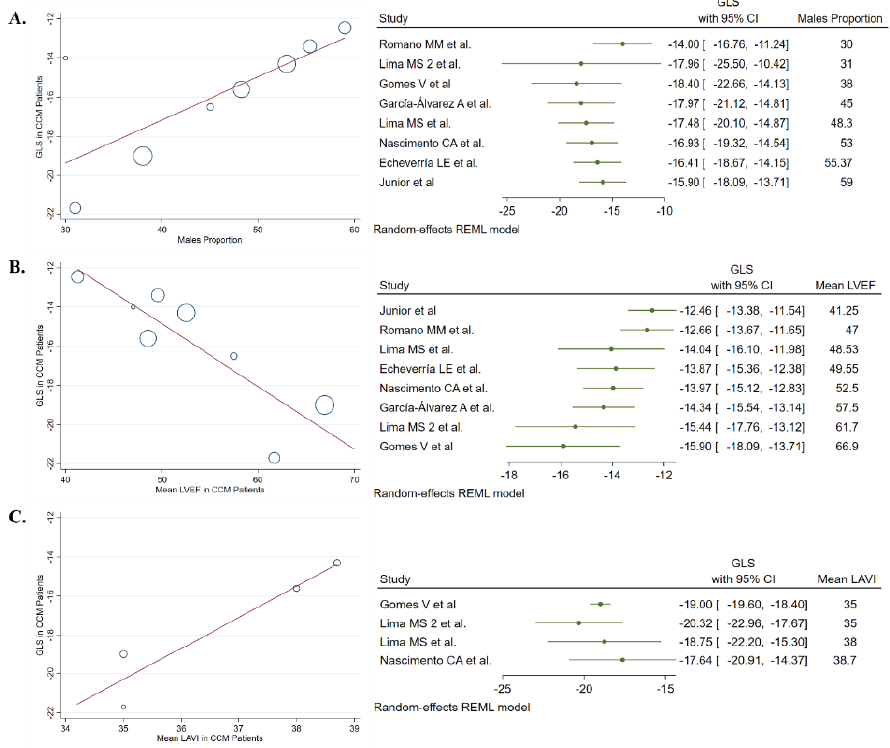
Figure 3. Meta-regression analyses revealed a significant association between ( A ) males proportion, ( B ) left ventricle ejection fraction, and ( C ) left indexed atrial volume with the global longitudinal strain value in patients with chronic Chagas cardiomyopathy.